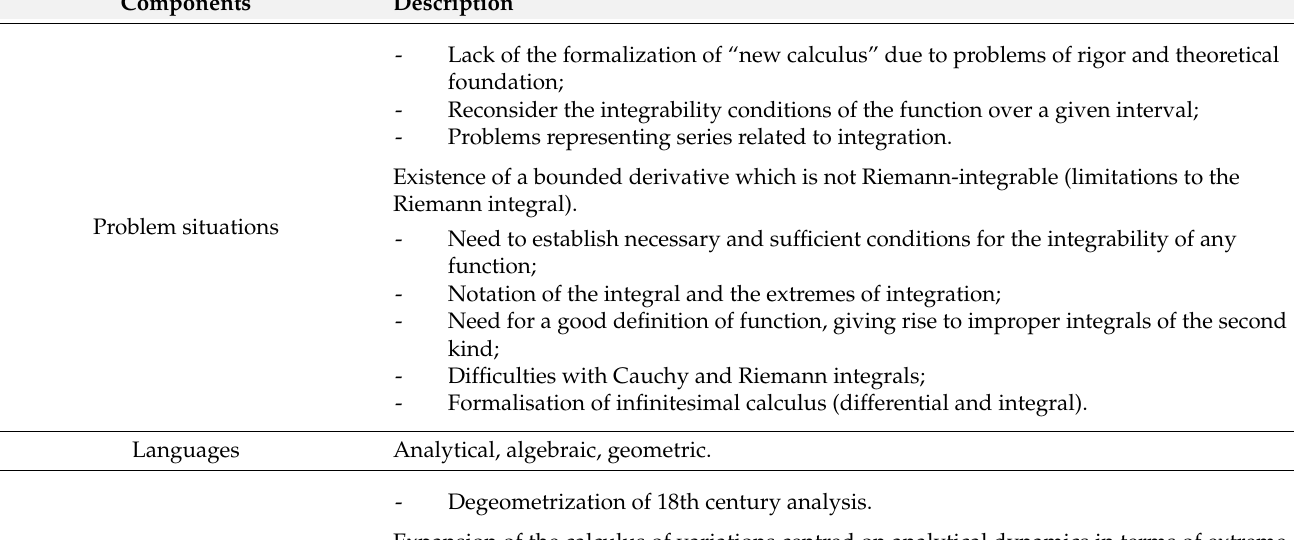
Table 4. GEC3 Integral Calculus